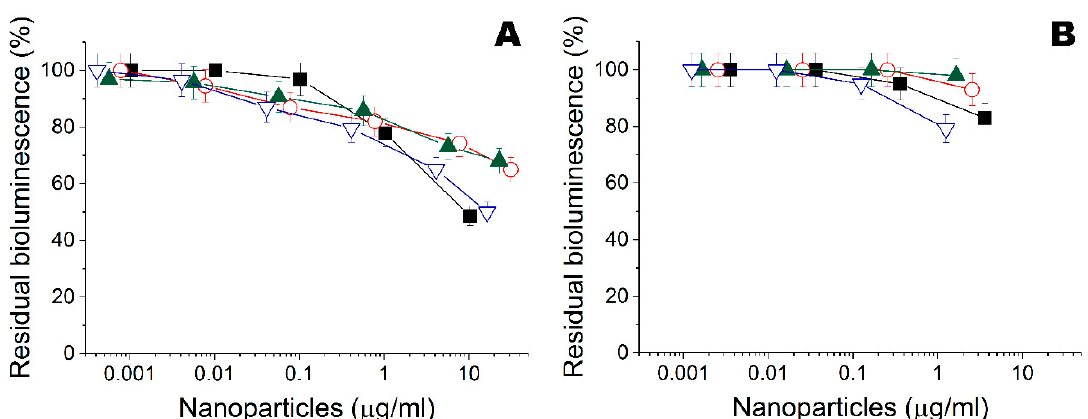
Figure 3. ( A ) Residual intensity of bioluminescence of immobilized cells Photobacterium phosphoreum treated by the Fe ( ), Ta ( ), Ti ( ▲ ), and Zn ( ) nanoparticles obtained in ethanol. ( B ) Residual intensity of bioluminescence of immobilized cells P. phosphoreum treated by the Fe ( ), Ta ( ), Ti ( ▲ ), and Zn ( ) nanoparticles obtained in water.